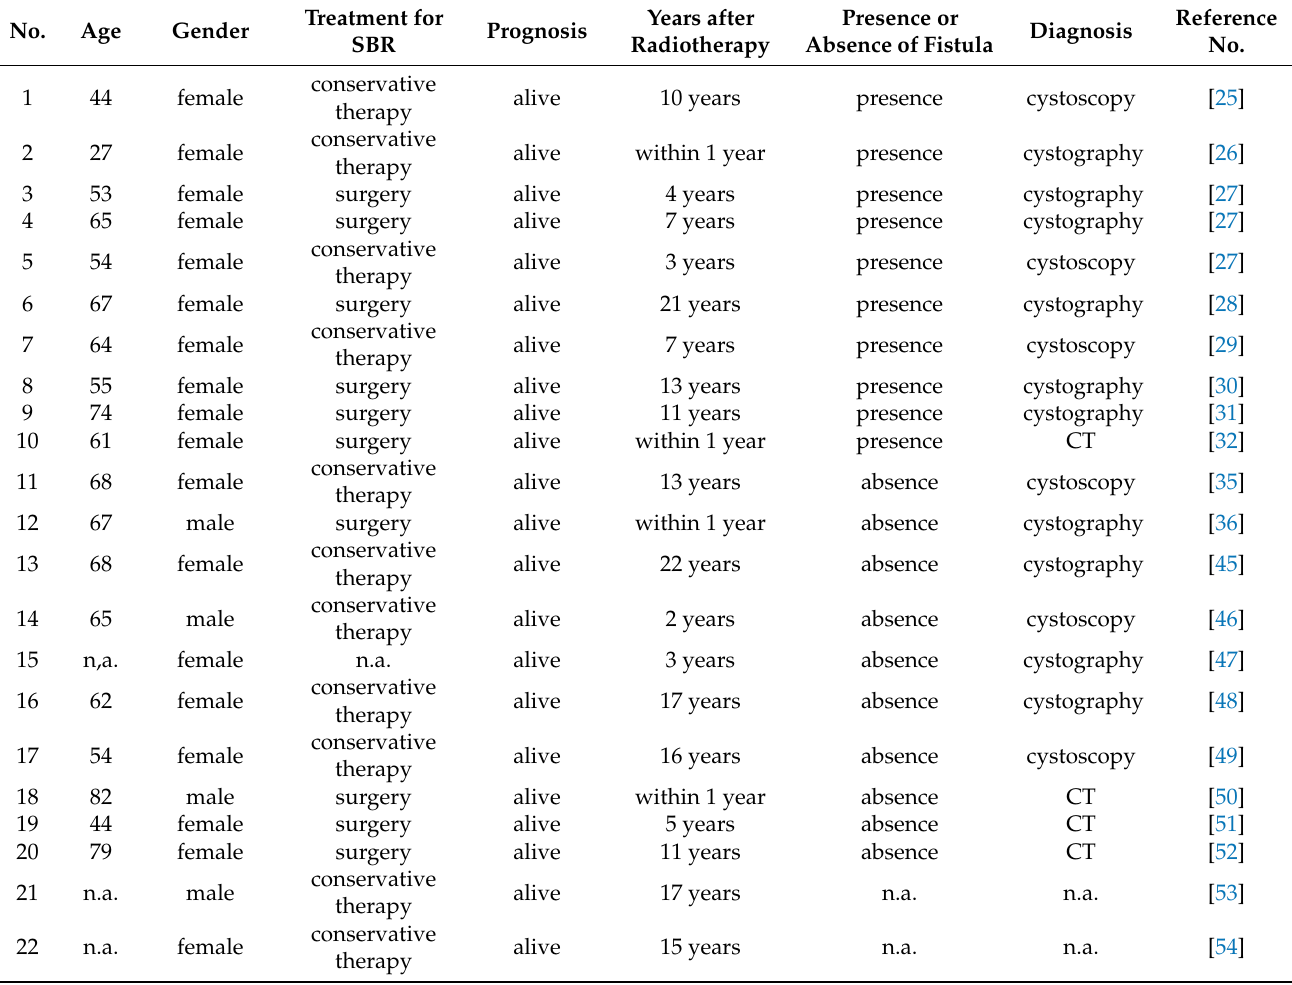
Table 1. Summary of 25 cases of spontaneous bladder rupture after radiotherapy. CT—computed tomography; n.a.—not applicable; No.—number; SBR—spontaneous bladder rupture.